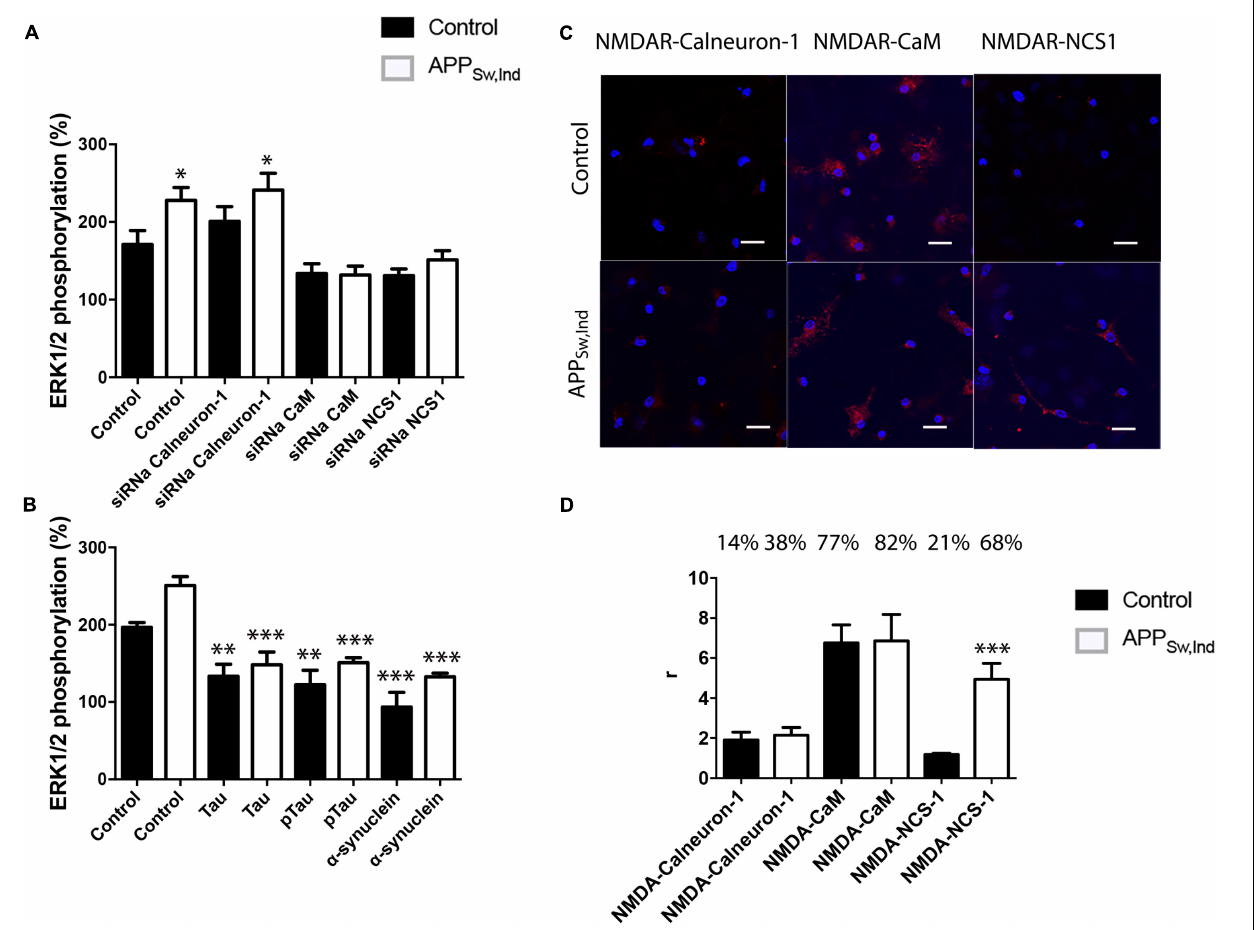
FIGURE 5 | NMDAR-mediated signaling in primary neurons from APP Sw , Ind mice. (A,B) Primary cultures from non-transgenic control (black bars) and APP Sw , Ind (white bars) embryos were isolated and transfected or not with siRNA for silencing calneuron-1, CaM, or NCS1. In (A) , neurons were treated with 15 µ M NMDA, while in (B) , neurons were previously treated with α -synuclein, Tau, or p-Tau for 2 h prior to 15 µ M NMDA addition; finally, ERK1/2 phosphorylation was measured. Values are the mean ± SEM ( n = 6). One-way ANOVA followed by Bonferroni’s multiple comparison post hoc test were used for statistics analysis. ∗ p < 0.05, ∗∗ p < 0.01, and ∗∗∗ p < 0.001 versus NMDA treatment; comparing only white (non-transgenic data) or only black (transgenic data) bars. (C) PLA performed in primary cultures from non-transgenic control (black bars) and APP Sw , Ind (white bars) embryos, using specific primary antibodies raised against NMDAR and calneuron-1, CaM, or NCS1. Confocal microscopy images (stacks of four consecutive planes) show heteroreceptor complexes as red clusters surrounding Hoechst-stained nuclei (blue). Scale bar: 15 µ m. The bar graph (D) shows the number of red dots/cell and the number above bars indicate the percentage of cells presenting red dots. Values are the mean ± SEM ( n = 5). One-way ANOVA followed by Bonferroni’s multiple comparison post hoc test was used for statistics analysis ( ∗∗∗ p < 0.001, versus